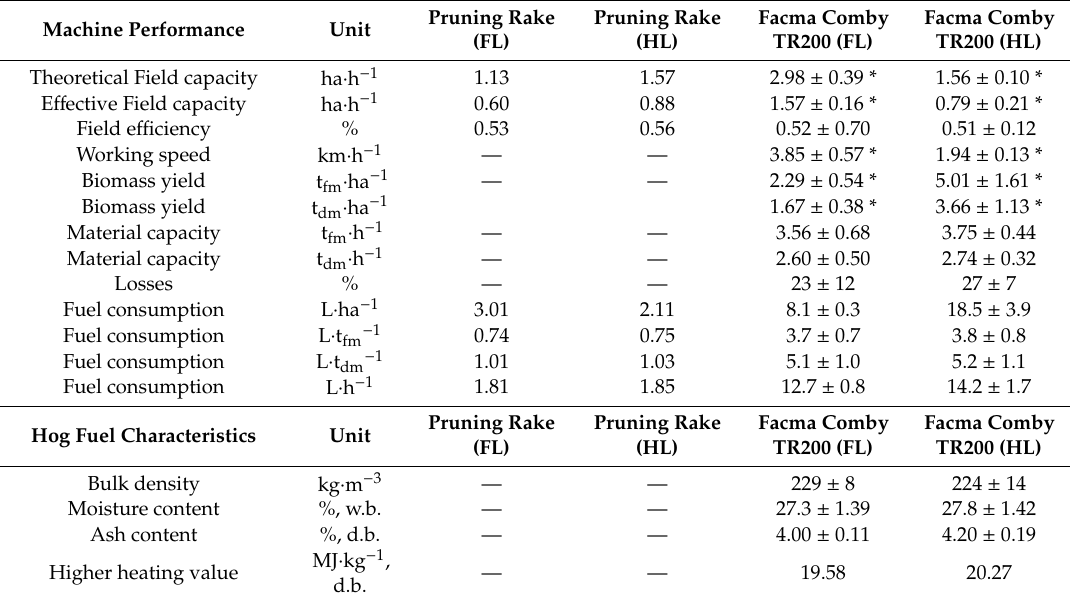
Table 3. Results of the statistical analysis regarding the machine performance of a pruning harvesting system on flat and hilly slopes and regarding hog fuel characteristics.